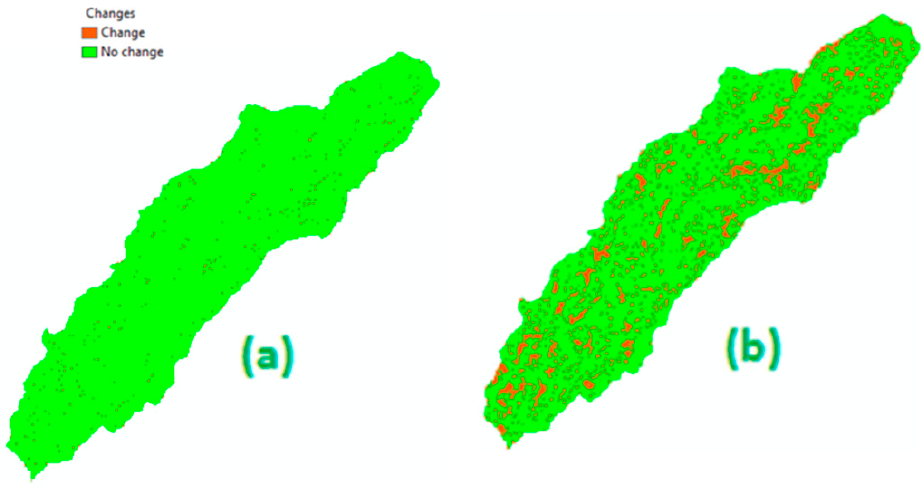
Figure 5. Difference map of ( a ) observed and simulated maps of 2009 and ( b ) simulated maps of 2009 and 2025.